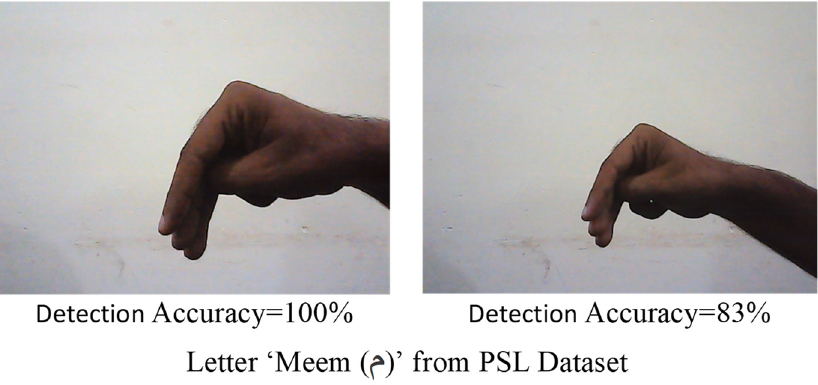
Figure 16. Processing variation in same hand gesture scenario 3.